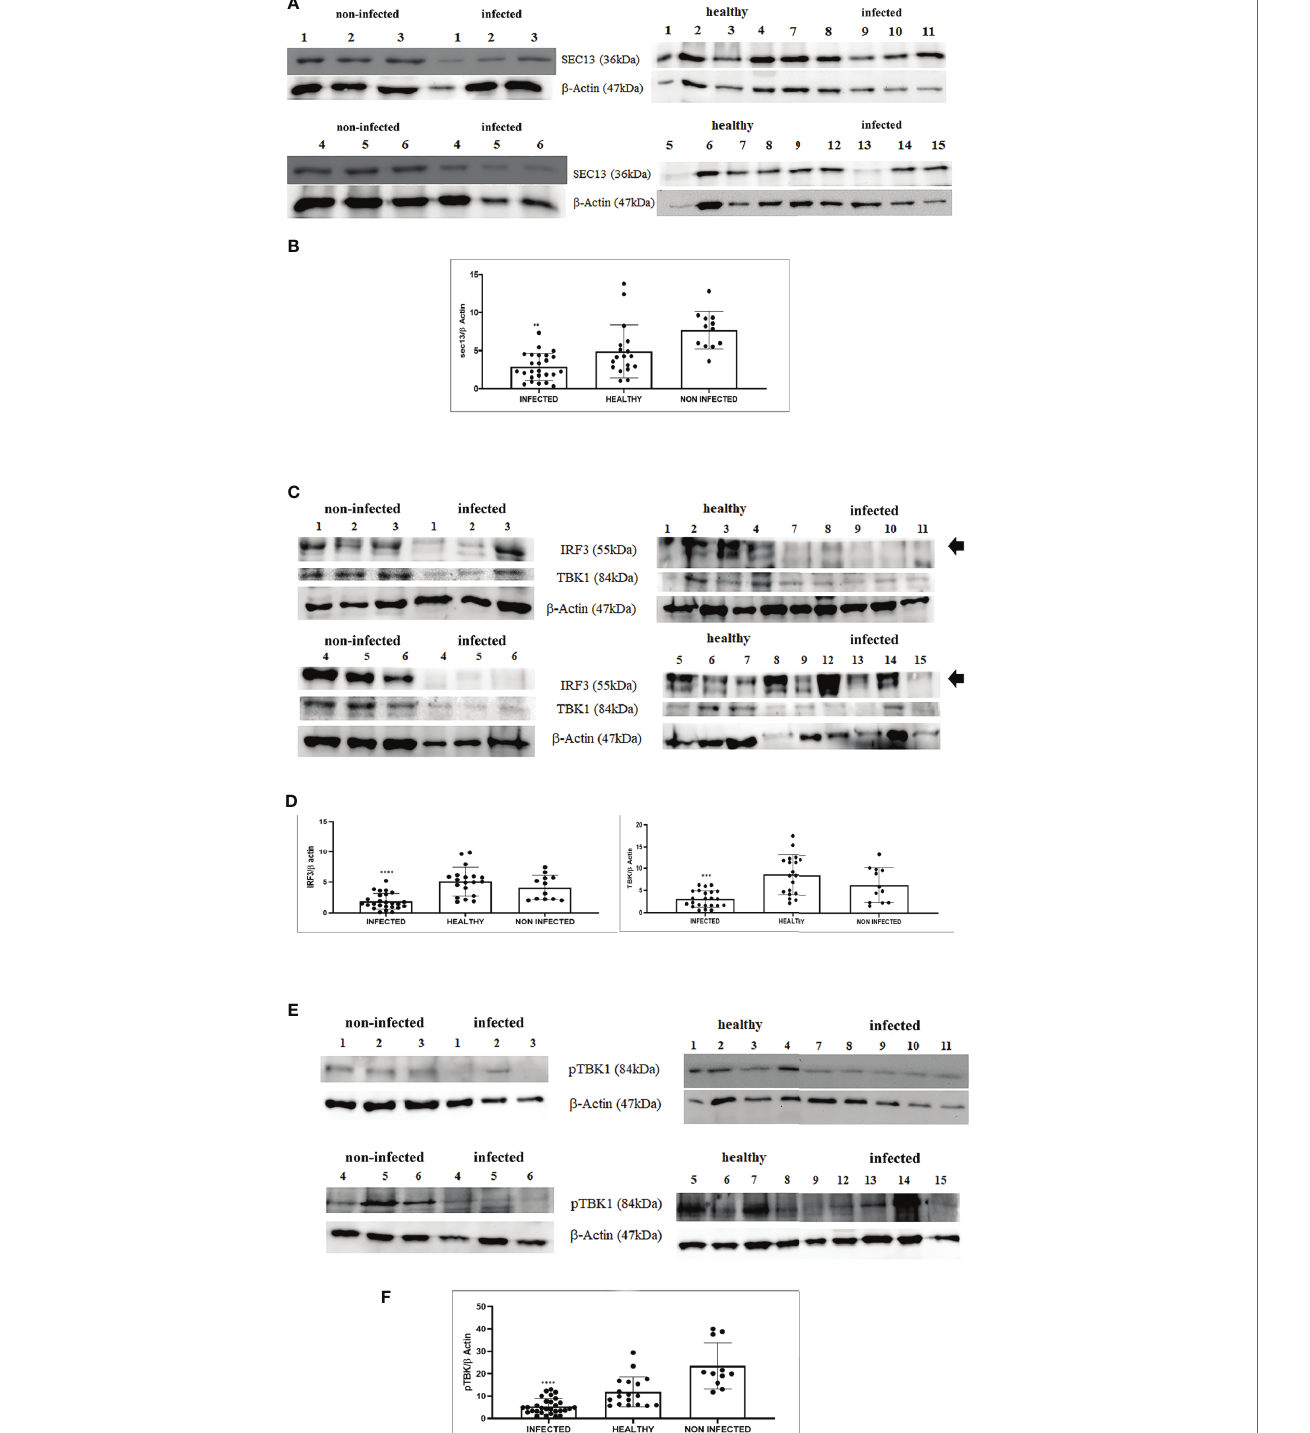
FIGURE 5 | (A) Western blot analysis of total Sec13 protein in infected, healthy and non-infected but in fl ammatory bladder samples. (B) Densitometric analysis of total Sec13 protein relative to the b -actin protein level (**p ≤ 0.01). Plots represent value found in each sample performed in duplicate. (C) Western blot analysis of IRF3 and TBK1 proteins in infected, healthy and non-infected but in fl ammatory bladder samples. (D) Densitometric analysis of both proteins was performed relative with the b -actin protein levels (***p ≤ 0.001; ****p ≤ 0.0001). IRF3 band used for densitometry was indicated by arrow. Plots represent value found in each sample performed in duplicate. (E) Western blot analysis of phosphorylated TBK1 (pTBK1) in infected, healthy and non-infected but in fl ammatory bladder samples. (F) Densitometric analysis of pTBK1 protein relative to b -actin protein levels (****p ≤ 0.0001). Plots represent value found in each sample performed in